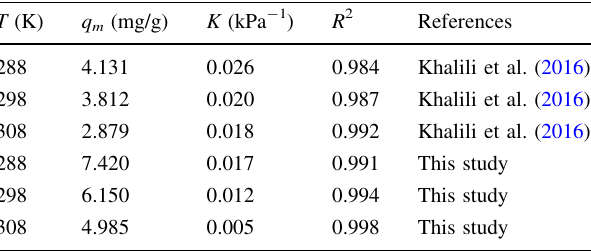
Table 1 Constant model parameters for the Langmuir isotherm at different temperatures compared with literature T (K) q m (mg/g) K (kPa - 1 ) R 2